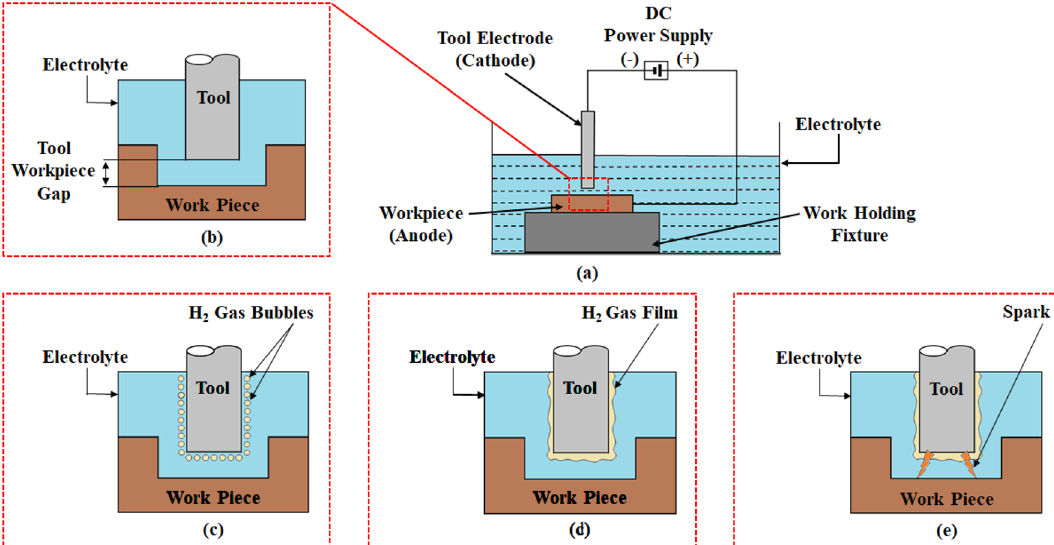
Figure 1. Conventional µ-ECDM process mechanism for conductive workpiece ( a ) schematic ( b ) magnified view of the machining zone ( c ) formation of the gas bubbles ( d ) formation of gas film thickness ( e ) occurance of